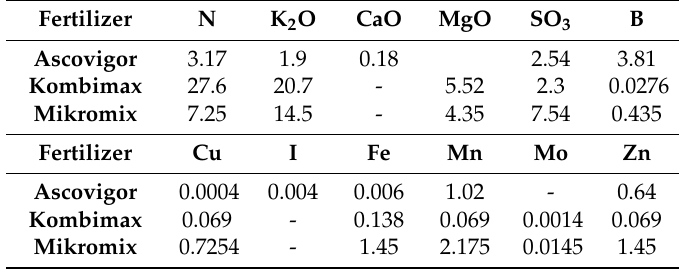
Table 1. Composition of applied foliar fertilizers (% of total volume)